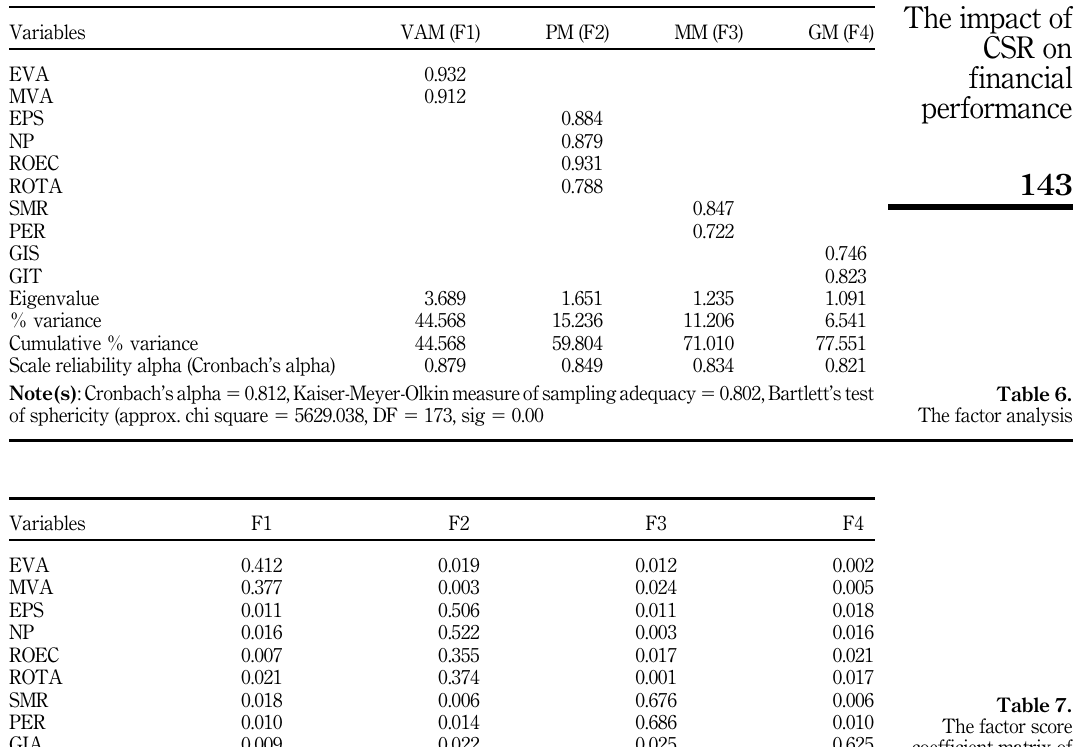
Table 7. The factor